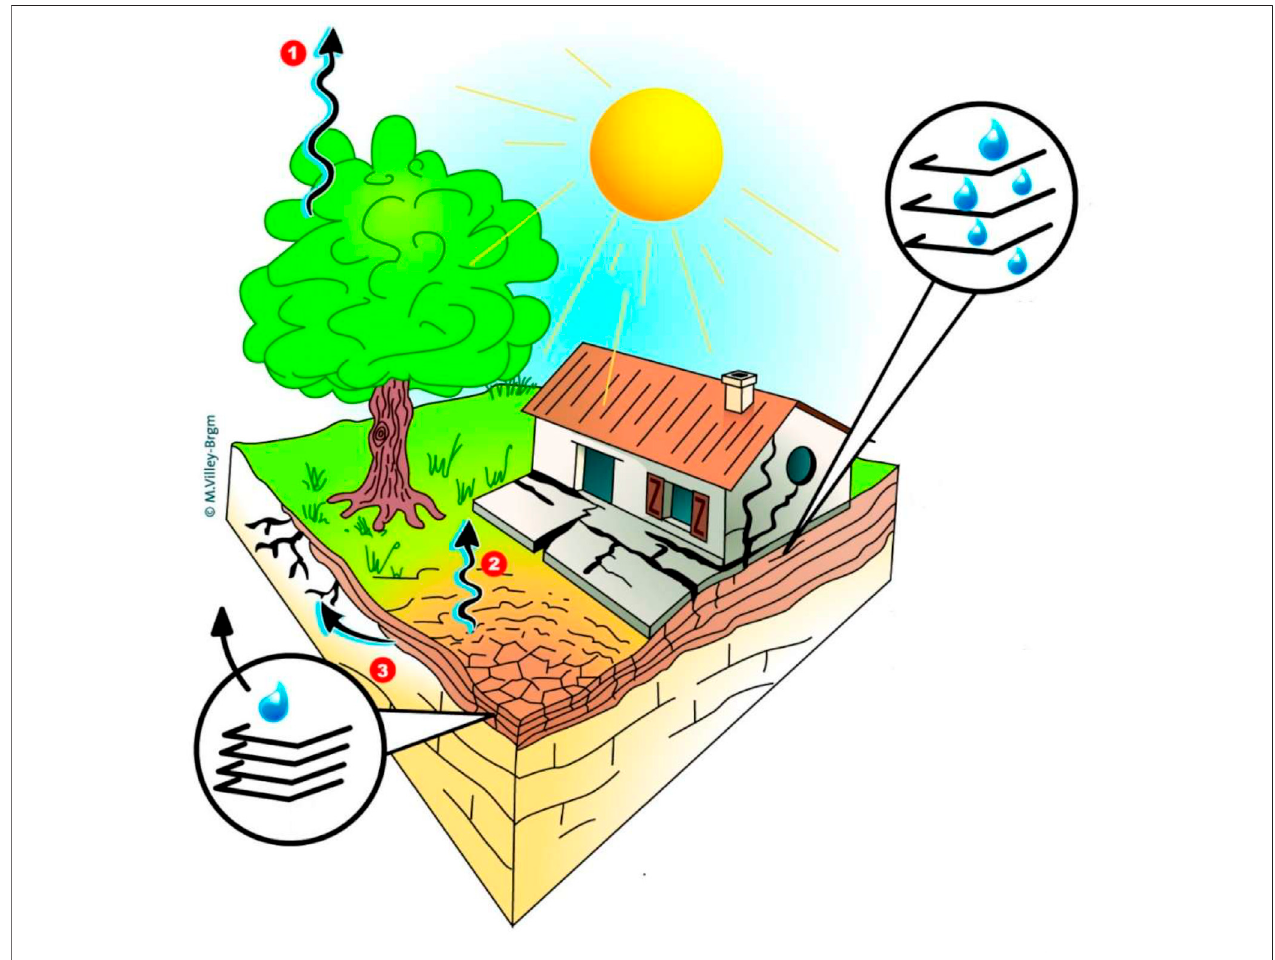
FIGURE 1 | Illustration of shrink-swell clay, (1) evapotranspiration, (2) evaporation and (3) root absorption (Villey, 2010).